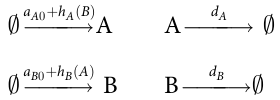
= 4 (top) and t = 20 (bottom) time m m = 0.5, a = 0.5, a = a = 700, k = A 0 B 0 A B A